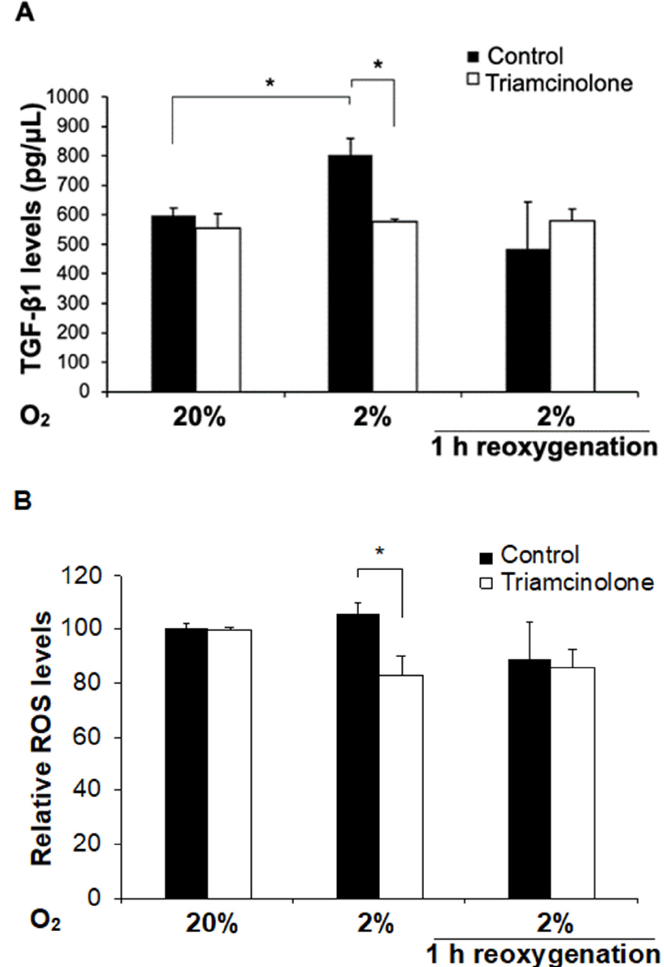
Figure 3. At 2% hypoxia, triamcinolone decreases reactive oxygen species formation and prevents TGF-b1 secretion while not having an effect at normoxia or after reoxygenation. Human fibroblasts treated with either vehicle or 1 mM triamcinolone were incubated at 20% or 2% O 2 for 24 h or 2% O 2 , followed by reoxygenation for 1 h. ( A ) Equal amounts of cell culture supernatants were used to measure TGF- β 1 levels using ELISA ( n = 4 for 20% and 2%, n = 2 for 2% reoxygenation). * denotes p < 0.05, ns for rest. ( B ) Total cellular ROS (reactive oxygen species) levels were measured using CM-H 2 DCFDA ( n = 4). * denotes p = 0.028 for 2% control vs. triamcinolone only; ns for rest.